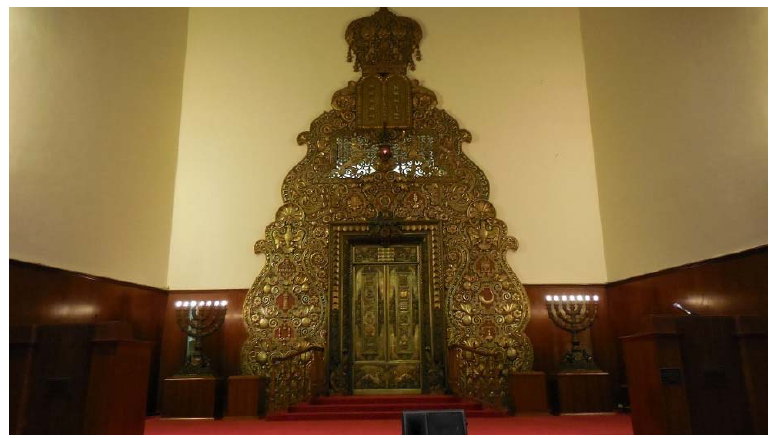
Figure 1. Torah Ark and bimah, Forest Hills Jewish Center, 1949 (photographed 2017 by the author).